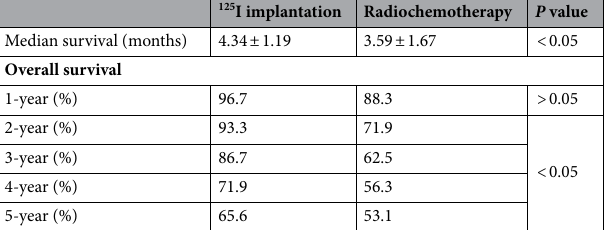
Table 3. Comparison of survival of patients treated with 125 I implantation with conventional